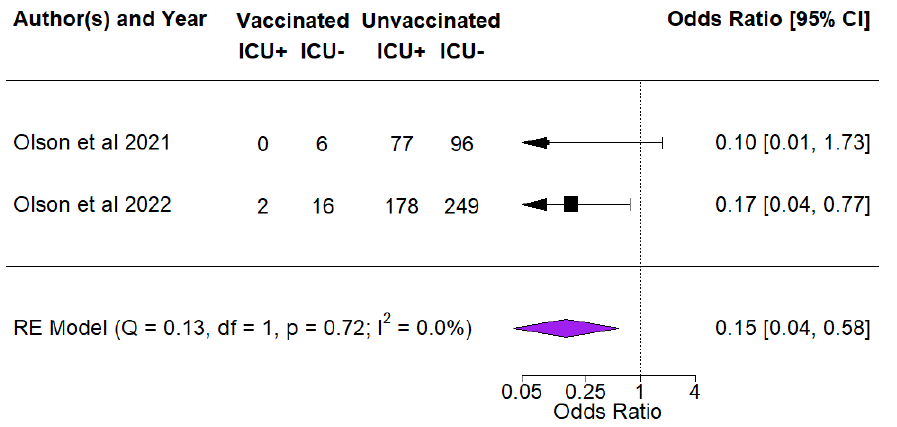
Figure 4. Vaccine effectiveness against admission into ICU [35,36]. The black square symbol presented for each study represents its point estimate, and the size is proportional to the weight of the study in relation to the pooled estimate. The red diamond symbol represents the overall effect estimate from the meta-analysis.